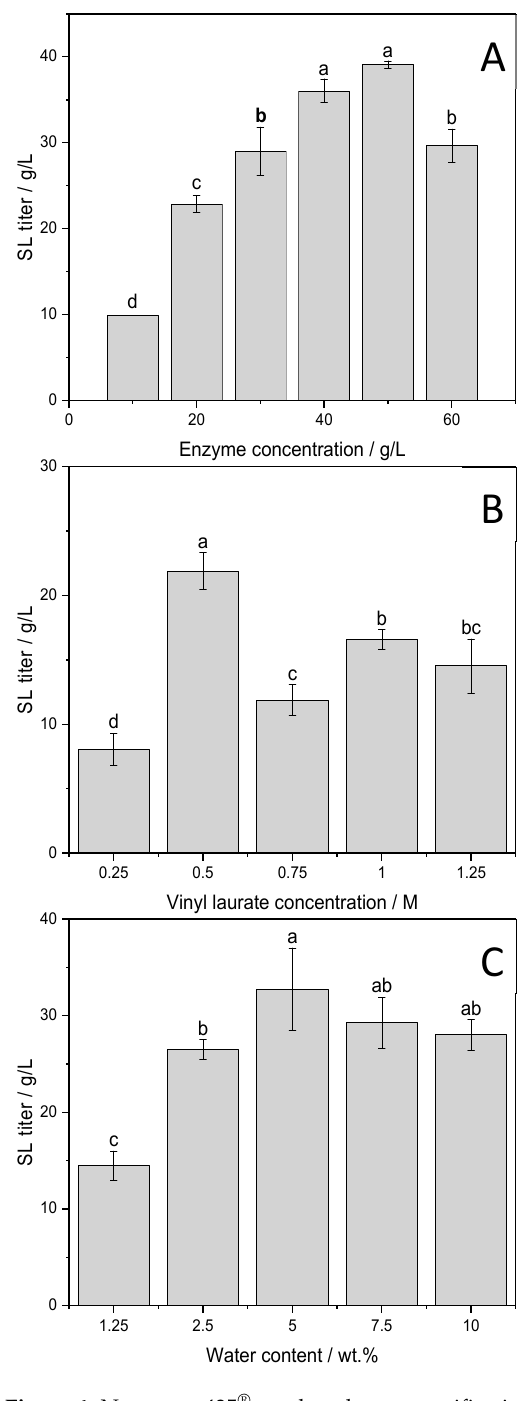
Figure 4. Novozym 435 ® -catalyzed transesterification of sorbitol and vinyl laurate in “2-in-1” Sorbit deep eutectic system: Effect of enzyme dosage ( A ); vinyl laurate concentration ( B ); water content in the media ( C ) on the titer after 48 h. a–d show statistically significant differences, at a 0.05 significance level, of the mean values obtained from three independent experiments ran under each